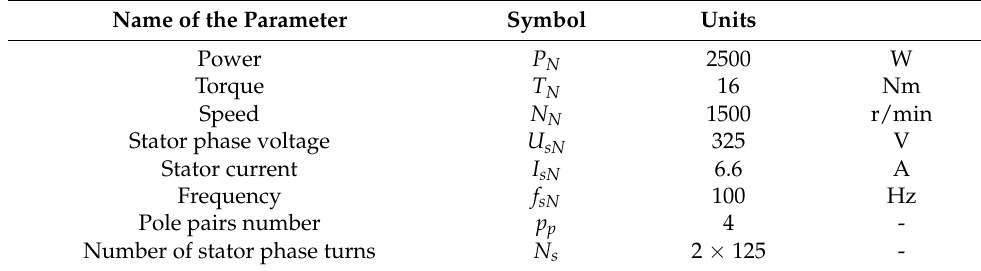
Table A1. Rated parameters of the tested PMSM. Name of the Parameter